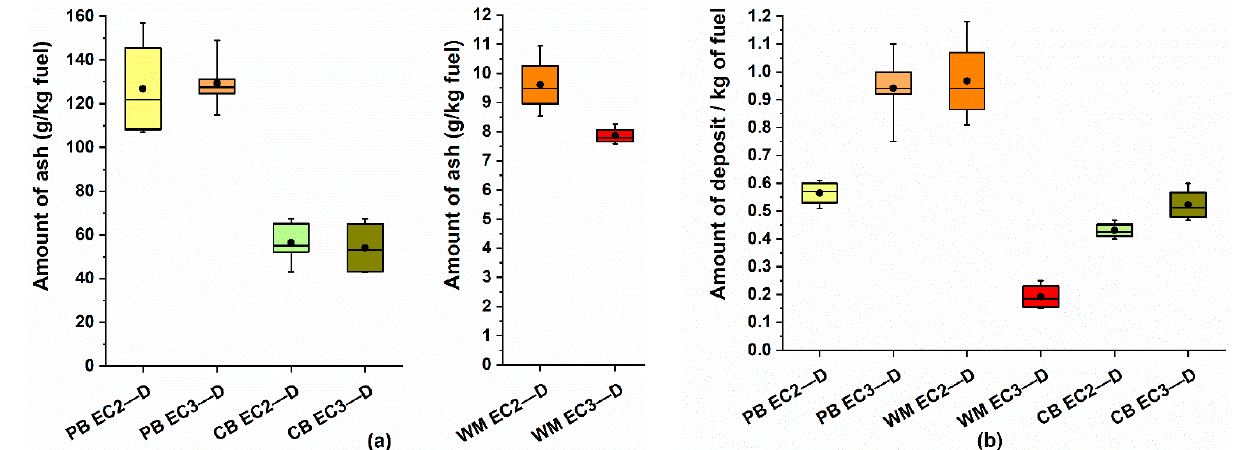
Figure 1. Amounts of ash ( a ) and deposits ( b ) formed by the combustion of 1 kg of fuel.